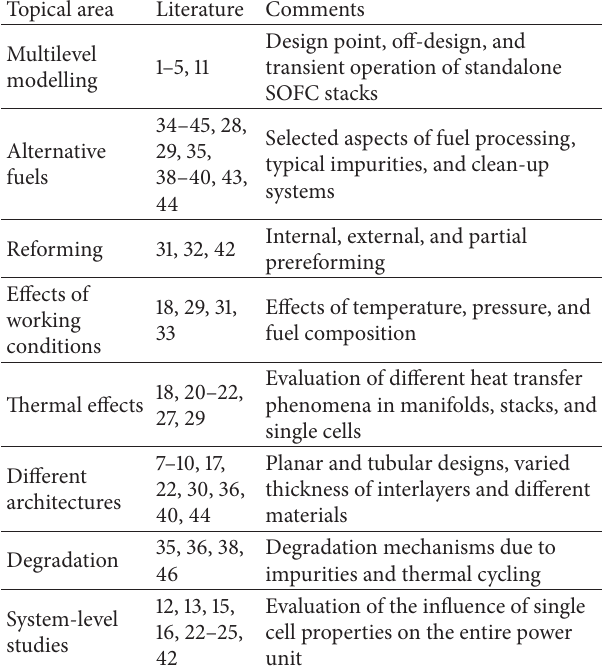
Table 2: Existing literature on selected topical areas of modelling